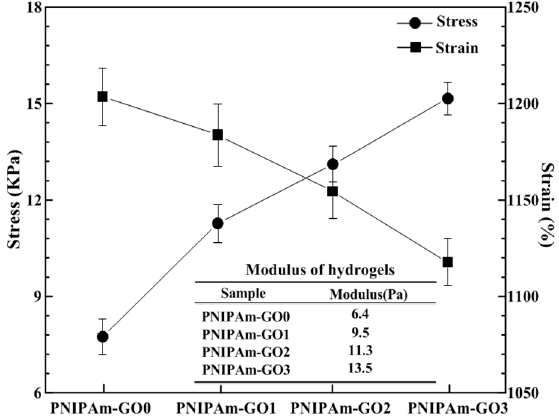
Figure 7. Stress, strain, and modulus values of PNIPAm hydrogels with various GO contents.